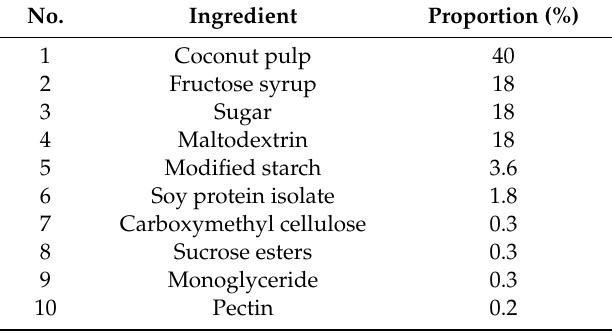
Table 1. Detailed ingredient ratios of coconut jam (proportion of ingredients added per 100 g of coconut jam). No. Ingredient Proportion